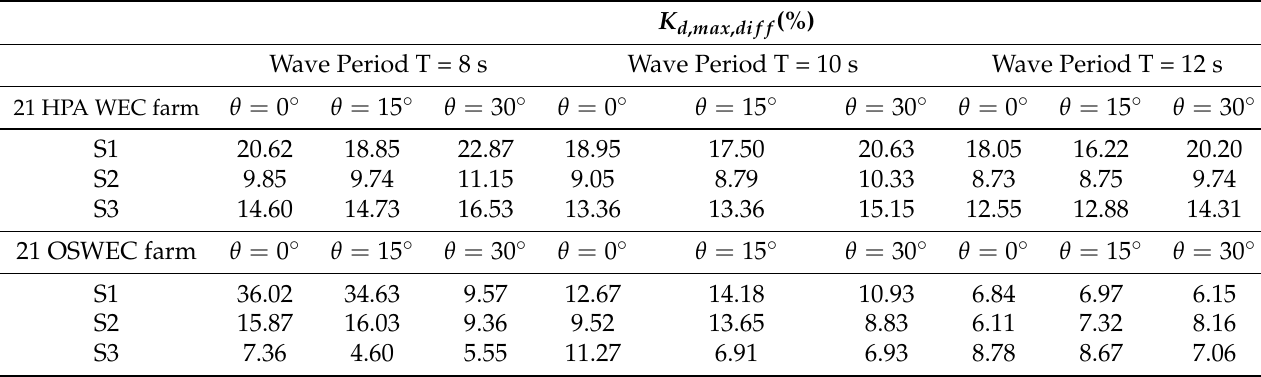
Table 2. K d , max , dif f (%) at x = 0 m for three different transversal cross-sections S1, S2 and S3 as indicated in Figure 6 for a 21 HPA WEC farm and a 21 OSWEC farm interacting with regular waves of H = 2.0 m. K d , max , dif f (%) Wave Period T = 8 s Wave Period T = 10